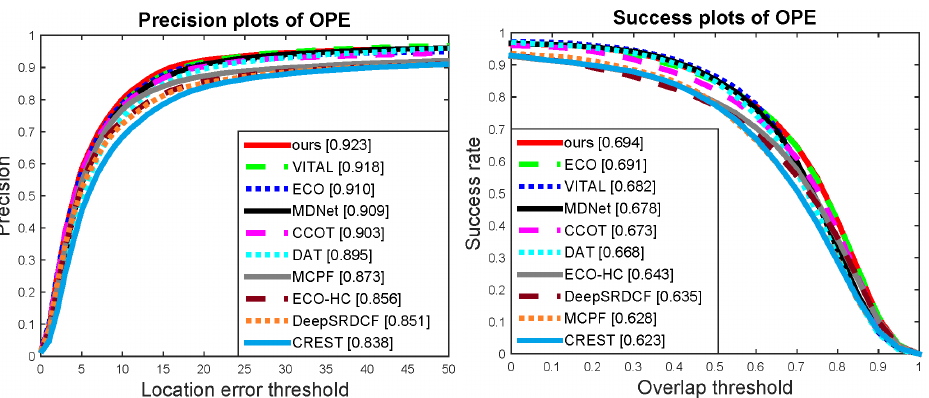
Figure 9. Precision plot and success plot for the OTB-2015 dataset. The AUV score and precision score of each tracker is shown in the legend. For clarity, we only show the top 10 trackers for performance. UAV123. UAV123 is constructed by 123 video sequences and more than 110K frames,